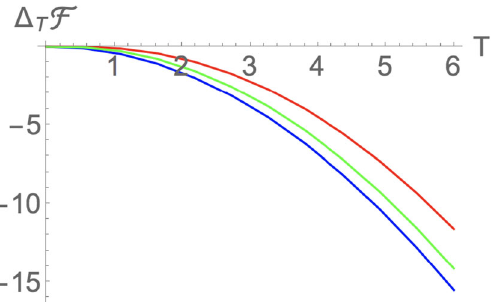
Fig. 4 Free energy (cid:8) T F , (23), as a function of T for the potential (56) for w 0 = 0 . 1 ,w 1 = 5 (blue), w 0 = 8 ,w 1 = 0 (red), w 0 = 3 ,w 1 = 2 (green). We have chosen for the lattice spacing a = 1